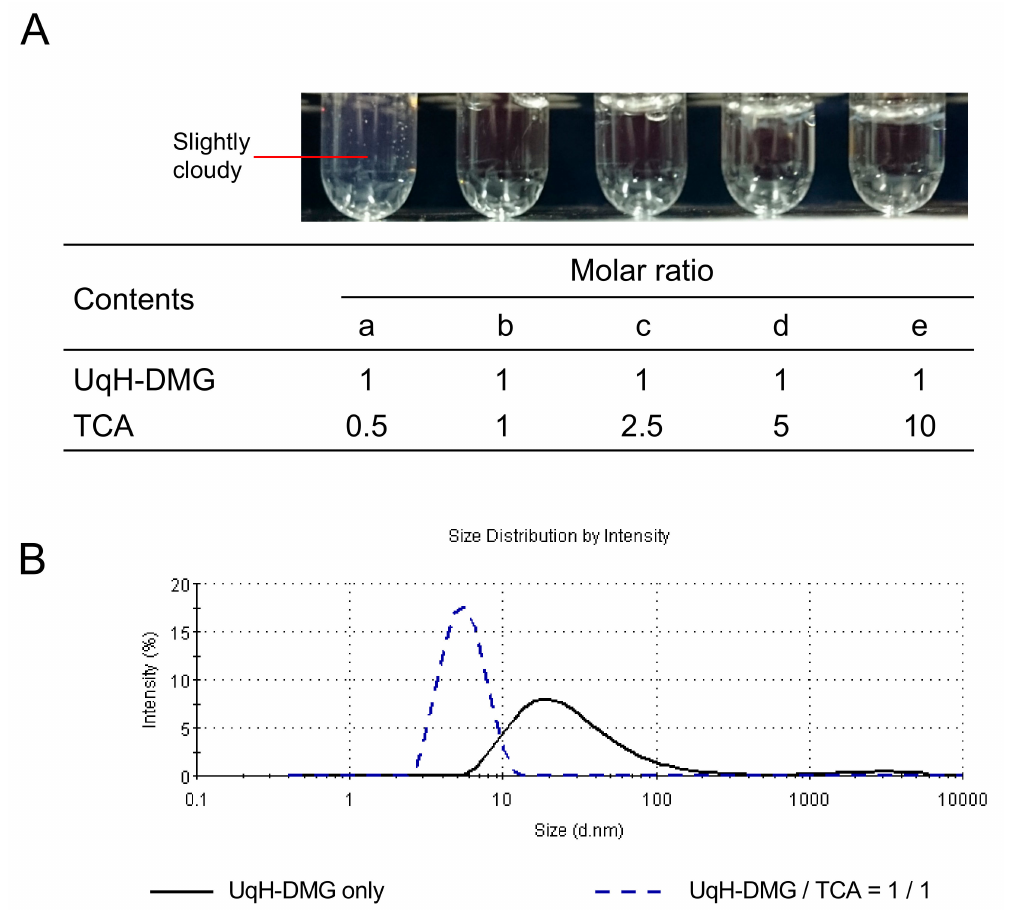
Figure 3. E ff ect of taurocholic acid on UqH-DMG solubility. ( A ) Appearance of mixtures of UqH-DMG and taurocholic acid (TCA) at di ff erent molar ratios. ( B ) Particle size distribution of UqH-DMG with or without TCA. Solid line: UqH-DMG only, dashed line: UqH-DMG:TCA at a molar ratio of